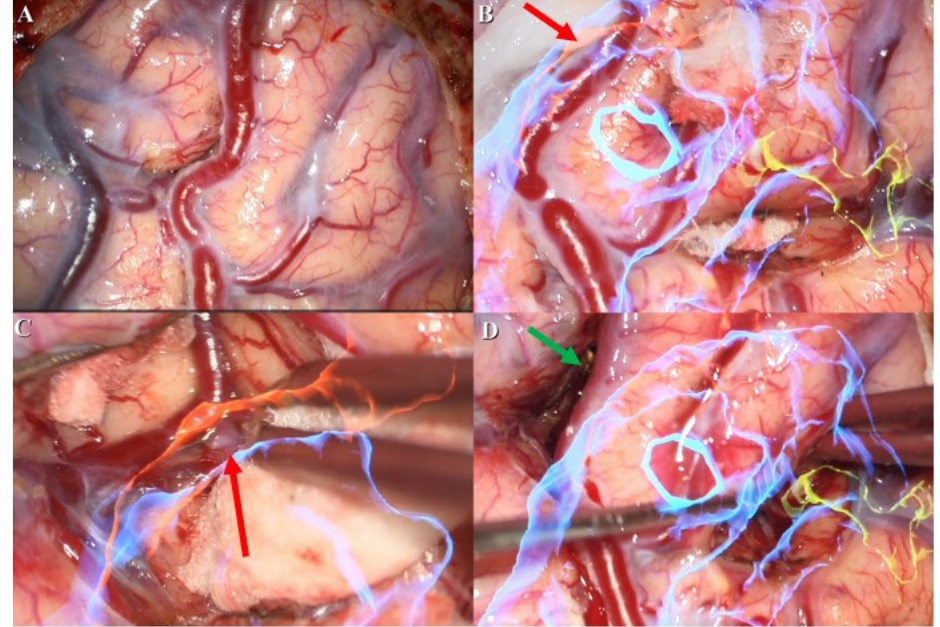
Figure 2. Microsurgery under assistance of AR technique. ( A ) Surgical field without AR hologram projection. ( B ) AVM nidus and feeding arteries were labeled with different color (blue: AVM nidus; red: feeding artery from middle cerebral artery; yellow: feeding artery from posterior cerebral artery); the red arrow also indicates feeding artery from middle cerebral artery. ( C ) Clipping and coagulation of the feeding artery. ( D ) Obliteration for another feeding artery from posterior cerebral artery; the green arrow indicates clip for feeding artery elimination.